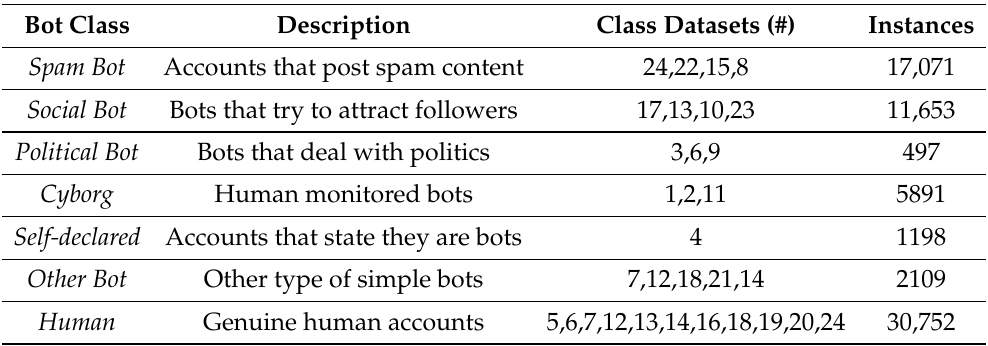
Table 2. Mapping of bot types and datasets and their description. The numbers of the datasets, refer to the serial number of each dataset, as presented in Table